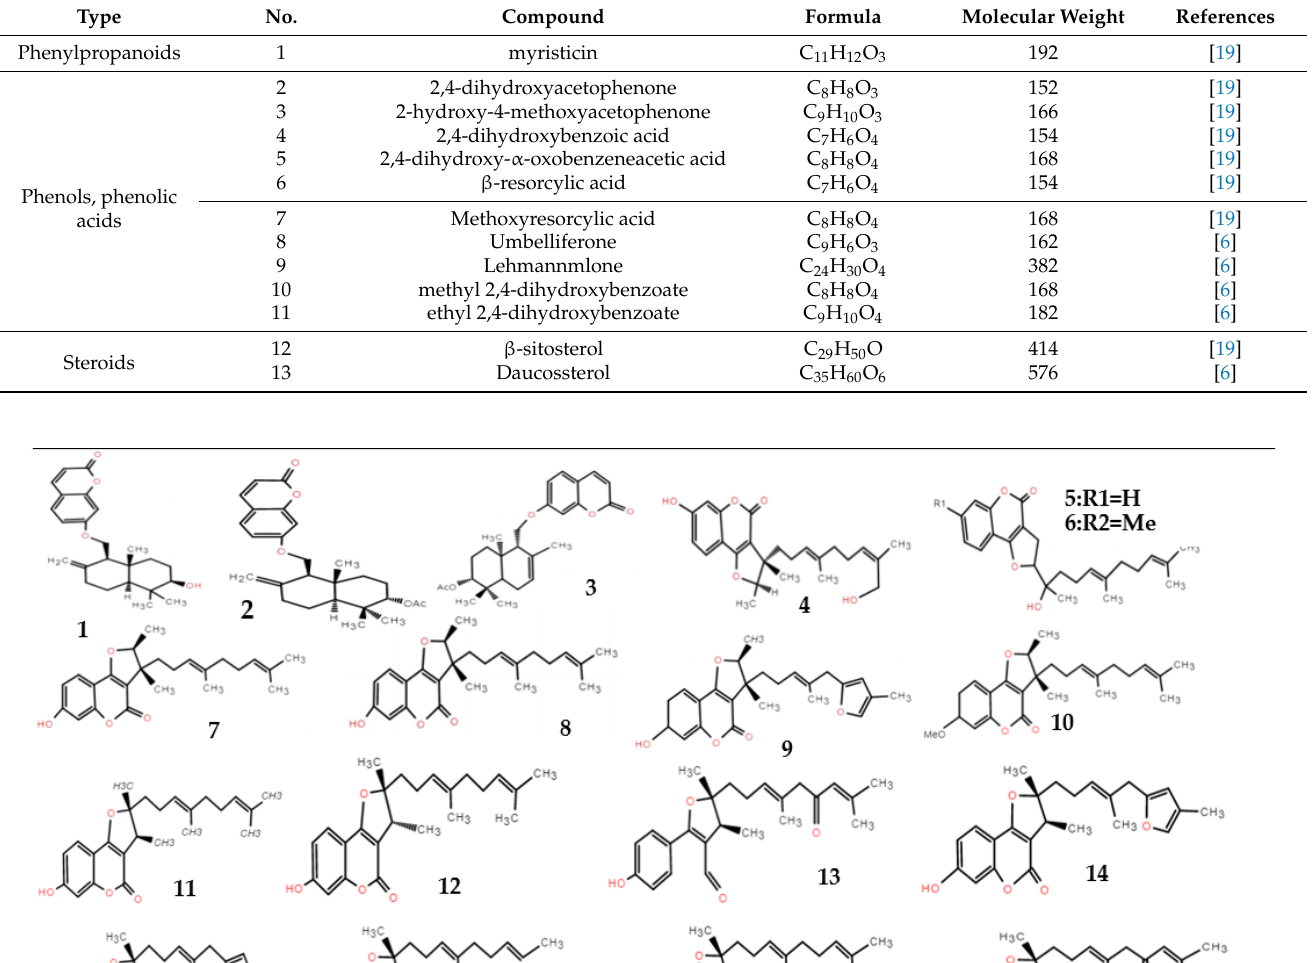
Table 3. Other chemical constituents of F. ferulaeoides.